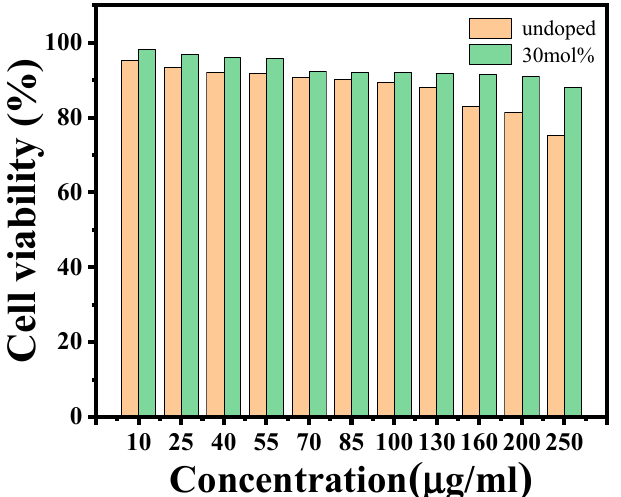
Figure 5. The effect of different concentrations of Cs 3 Bi 2 Cl 9 and Cs 3 Bi 2 Cl 9 :Ce 30% QDs on the viability of HepG2 cells after co-culture with HepG2 cells for 24 h as determined by MTT assay.